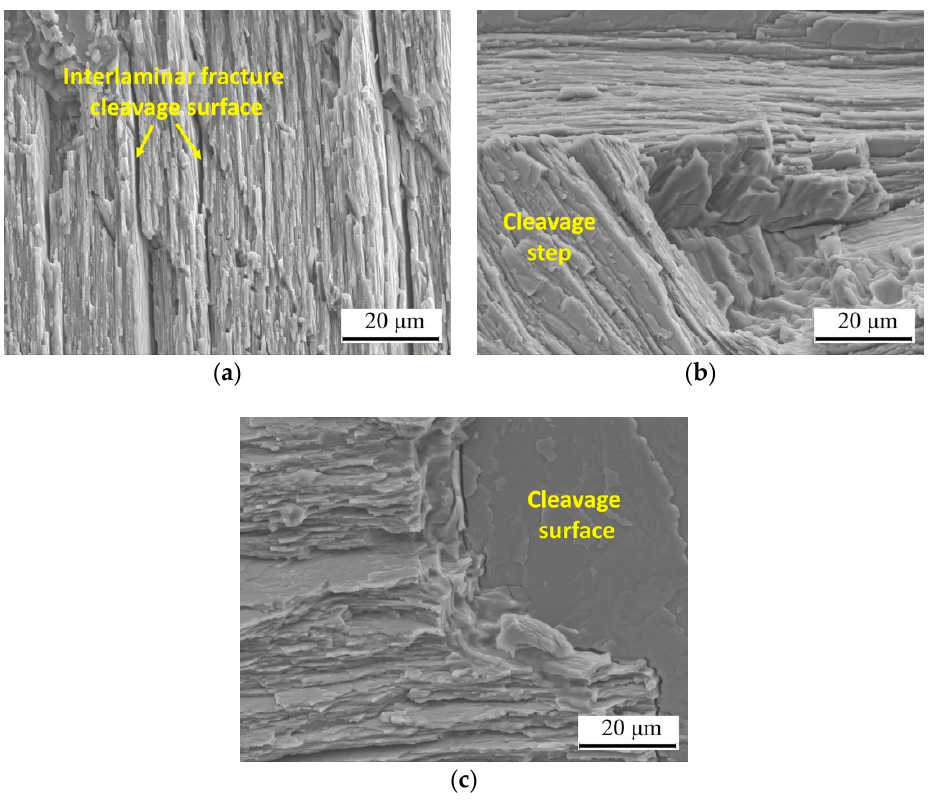
Figure 6. Fracture morphology of the tensile test at different growth rates: ( a ) V = 10 μ m/s; ( b ) V = 15 μ m/s; and ( c ) V = 20 μ m/s. ( b ) V = 15 µ m/s; and ( c ) V = 20 µ